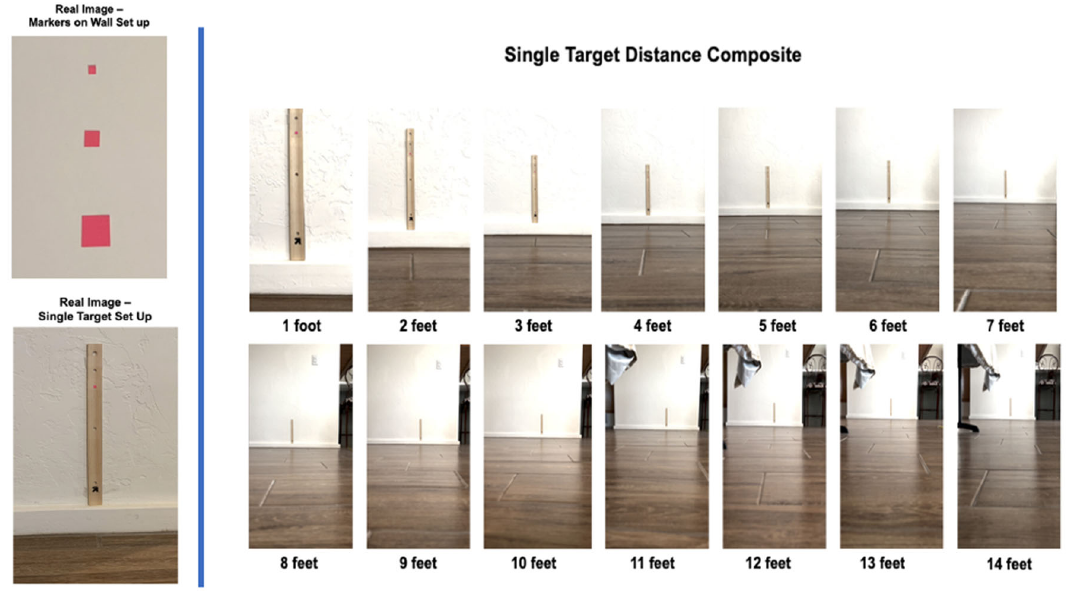
Figure 3. Actual images of experimental design set up of single target